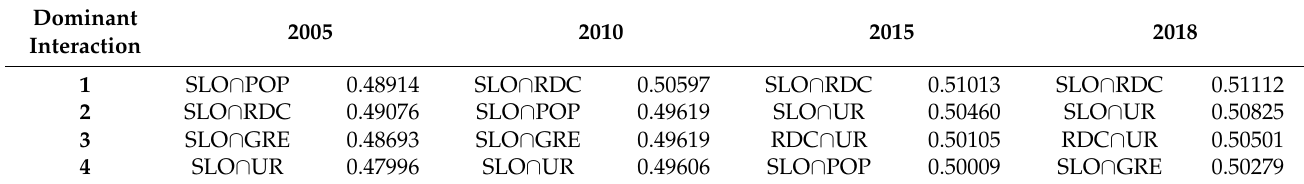
Table 5. GDM detection q statistic for interaction between factors on ESV. SLO, slope; RDC, river distance accessibility; GRE, per capita green area; UR, the proportion of urban and rural human settlements; POP, population.